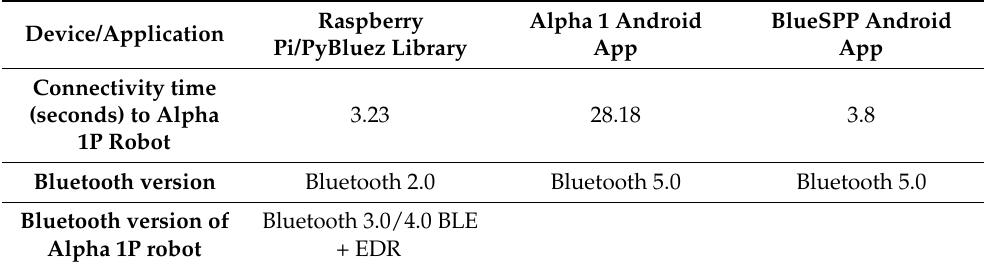
Table 7. Connectivity time results for Raspberry Pi, Alpha 1, and BlueSPP Android Apps.